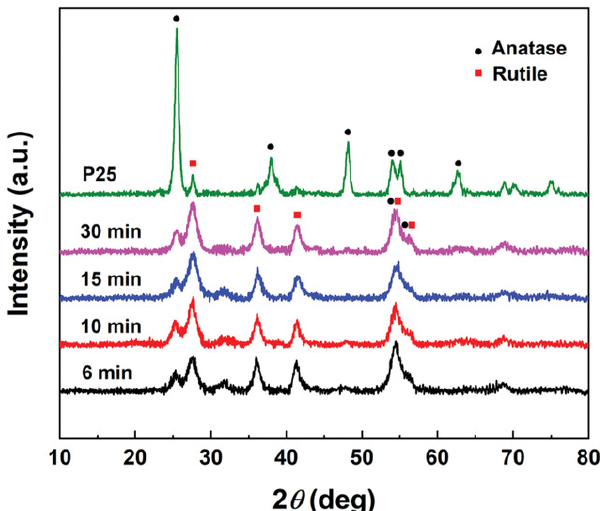
Figure 7. XRD patterns for titania NPs obtained at various levels of deposition time, compared with the pattern obtained for the commercial P25 TiO 2 [55] . Reproduced with permission from Wu, S., et al., Small Methods; published by Wiley Online Library, 2020.